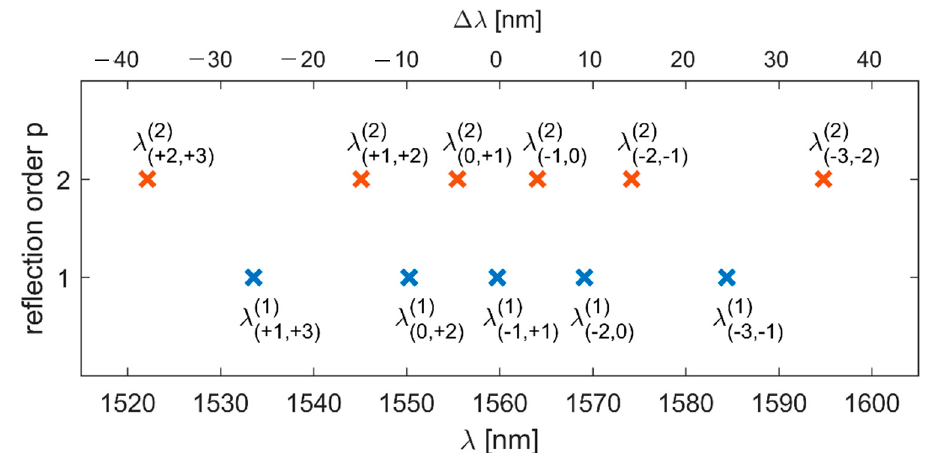
Figure 2. Calculated positions of Bragg reflection peaks λ (m,q)(p) , where m and q are the diffraction order number and p is the reflection order (p = 1 or 2). The auxiliary axis shows the difference between each position λ (m,q)(p) and the position of the central peak λ ( − 1,1)(1) .